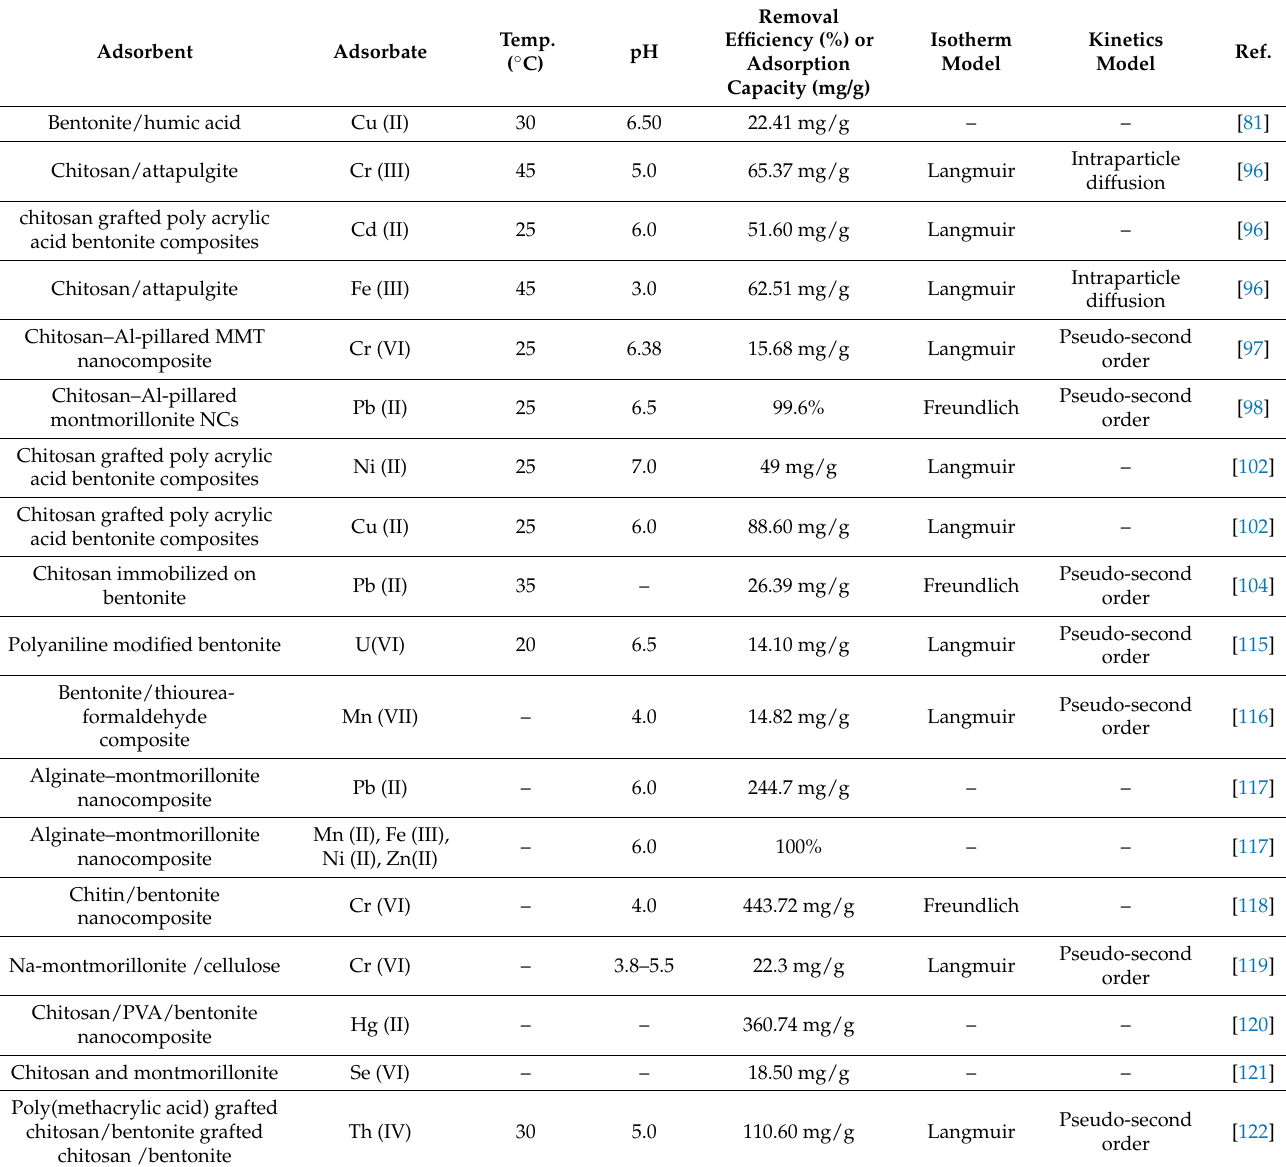
Table 3. Water treatment from different inorganic contaminants over clay-polymers nanocomposites (NCs) adsorbents. Adsorbent Adsorbate